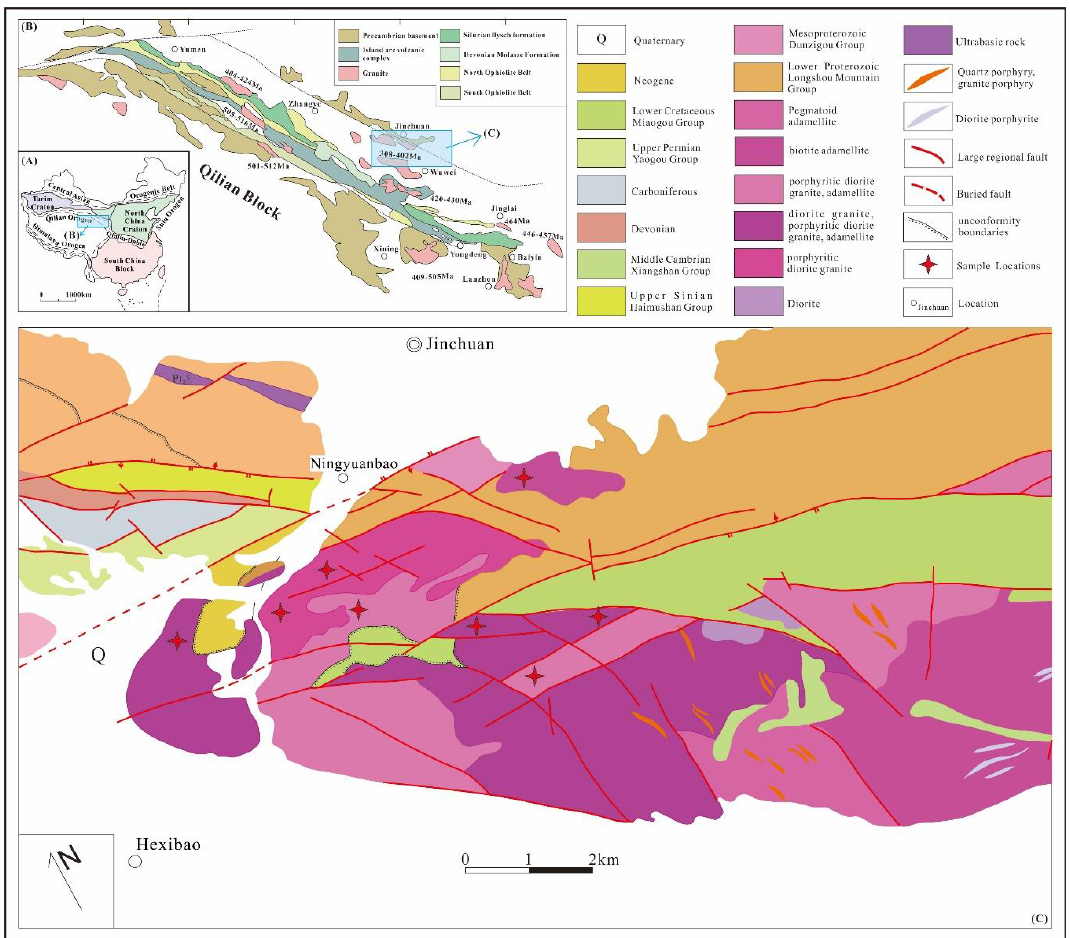
Figure 1. ( A , B ) Regional tectonic map of the Alashan uplift belt (based on Song et al. [12]). ( C ) Geological map of the Qingshanbao complex in the Longshou Mountain.